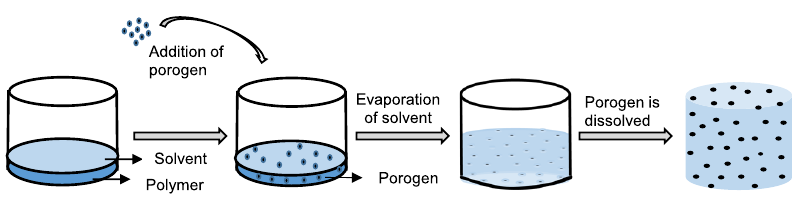
Fig. 1 Scheme of composite scaffold by solvent casting and particulate leaching fabrication